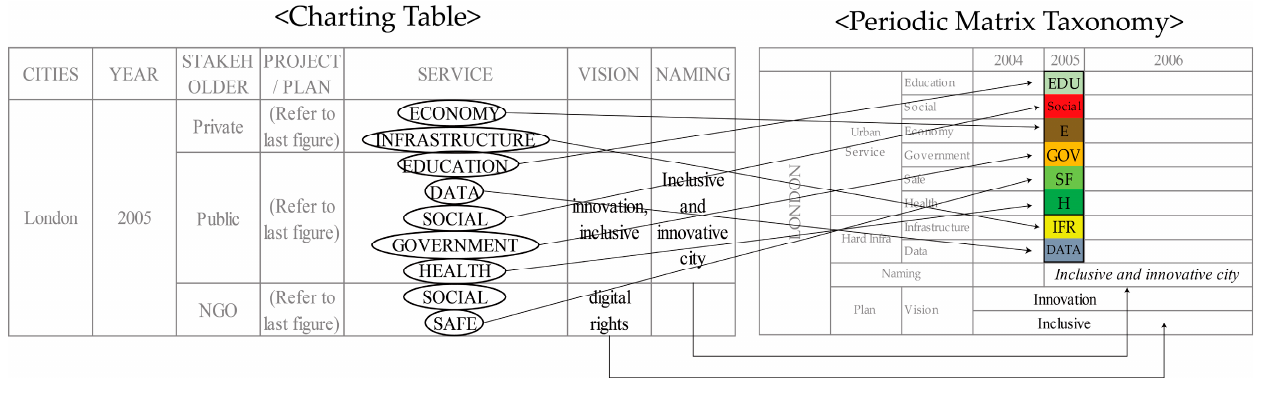
Figure 5. Coding Data.